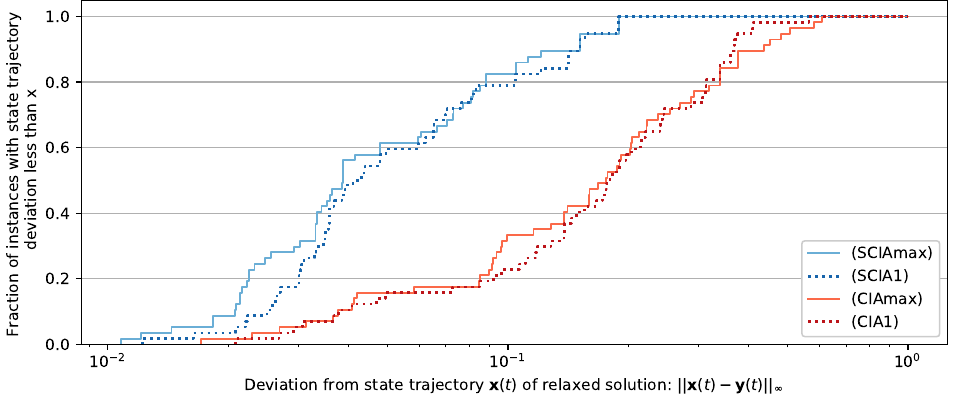
Figure 3. Performance profile comparing the deviation of differential states based on SCIA and CIA solutions. Relaxed solutions are shown in maximum norm and log-scale. The results are based on the instances “Double tank (Multimode)” and “Lotka–Volterra (absolute fishing variant)” from the mintoc.de benchmark library. Using (SCIA1) or (SCIAmax) can improve the performance of the CIA decomposition